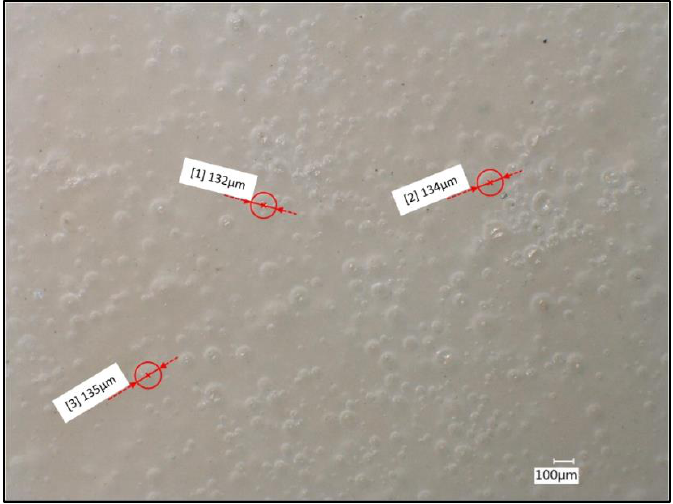
Figure 6. PHB/microsphere (3%) composite sample surface with measured pore diameters of fully formed microspheres. Image taken at 100 × under partial-ring lighting conditions.